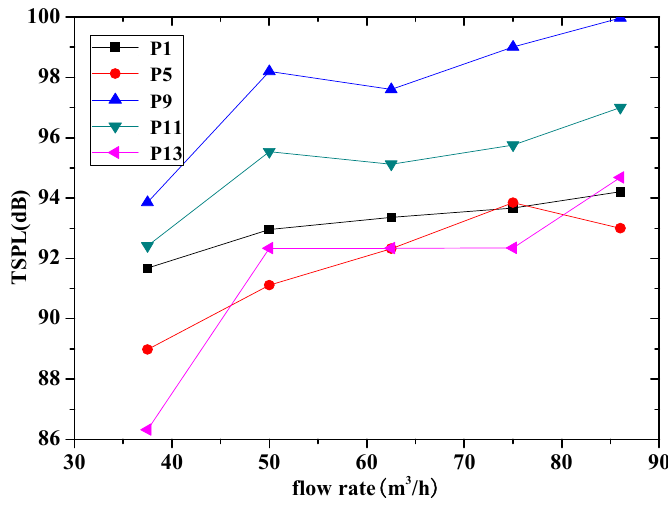
Figure 11. TSPL changing curves with flow rate (2900 rpm).